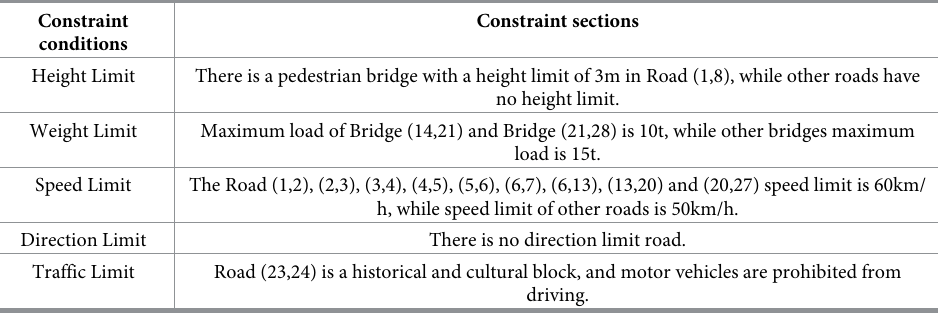
Table 3. Road constraint